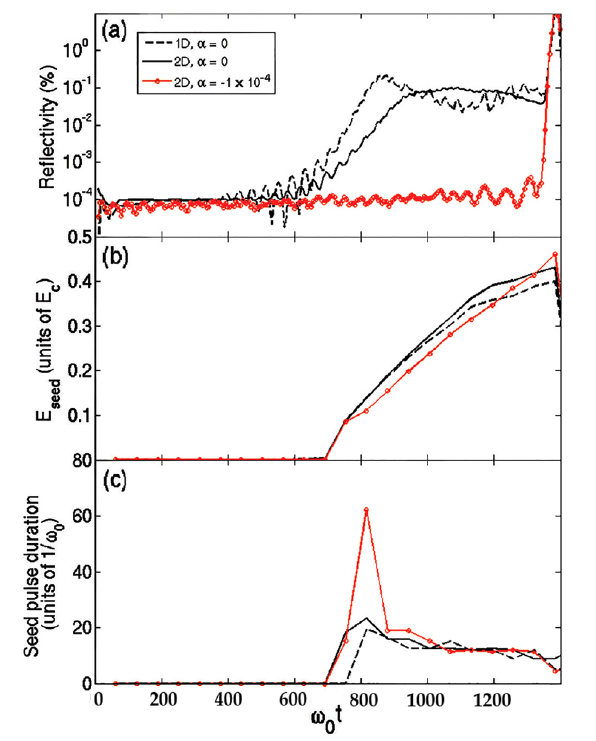
Figure 3. Temporal evolution of ( a ) the reflectivity, ( b ) the seed amplitude, and ( c ) the seed duration for unchirped and chirped pump laser beams in 1D and 2D geometries. The duration and the energy of the seed laser beam have been set equal to zero for time earlier than ω 0 t = 711 (time at which the seed beam enters the plasma). Here, ω 0 is the frequency of the pump (given as ω pump in the text). For the 2D geometry, the diagnostics were computed on axis. This figure was reprinted/adapted with permission from Ref. [183]. Copyright year: 2022, Publisher: American Physical